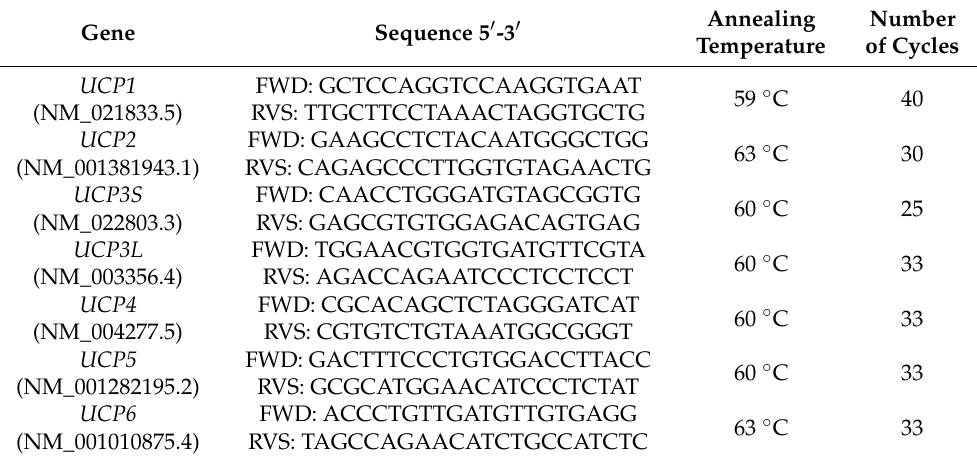
Table 1. Oligonucleotides and cycling conditions for RT-PCR amplification of mitochondrial uncou- pling proteins (UCPs)